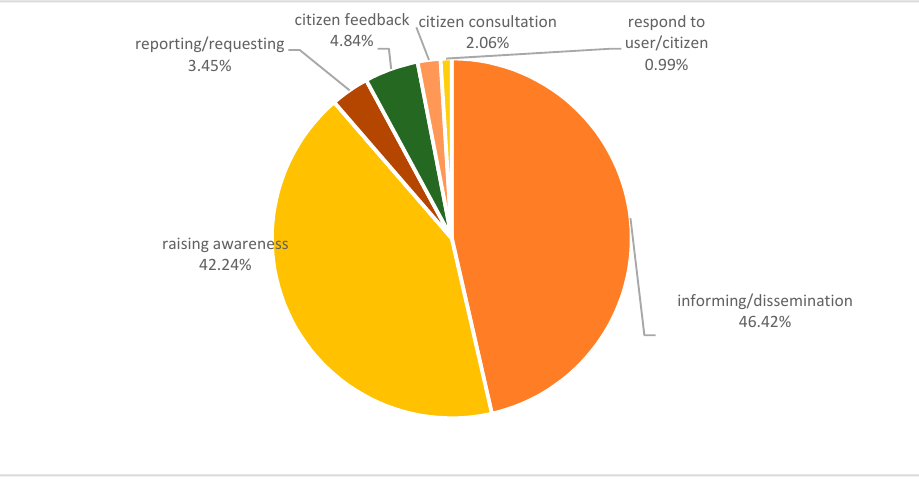
Figure 3. Categories of interaction identified in the DBMP Twitter account.